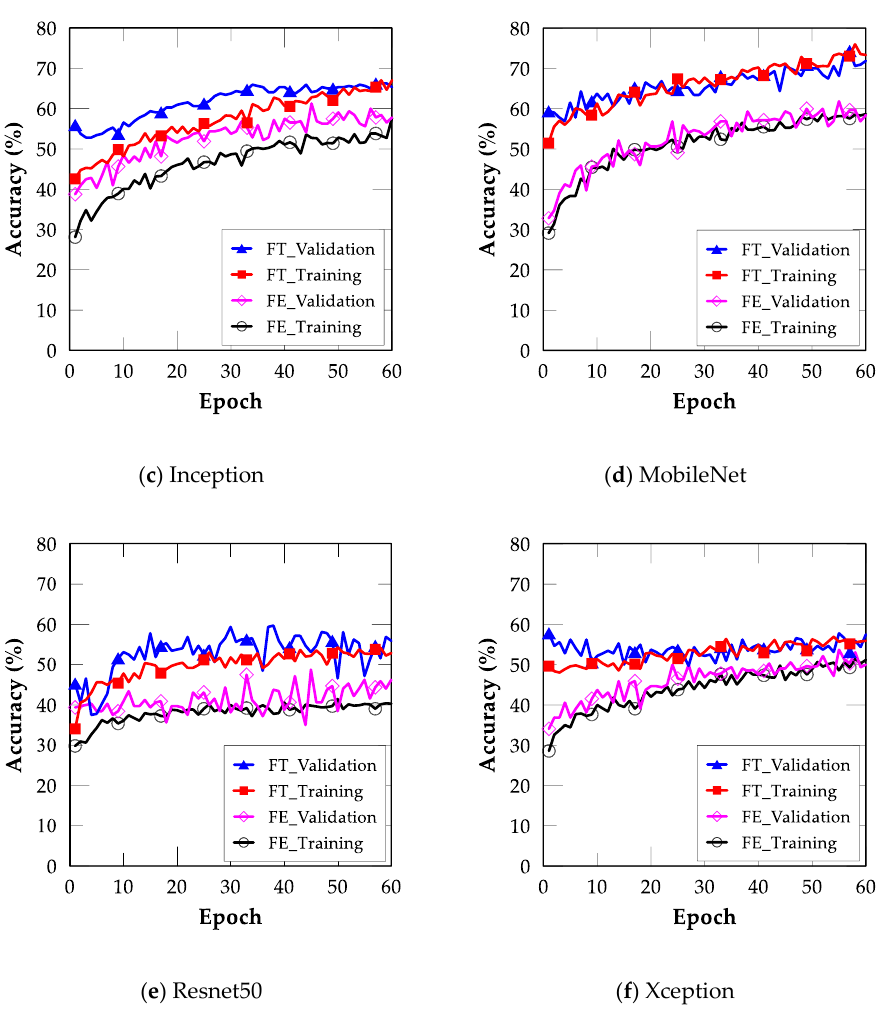
Figure 6. Training and validation accuracies of various CNN models implemented through TL: ( a ) VGG16, ( b ) VGG19, ( c ) Inception, ( d ) MobileNet, ( e ) ResNet50, and ( f ) Xception models. The results of the testing accuracy analyses for all the models are presented as bar charts in Figure 7.